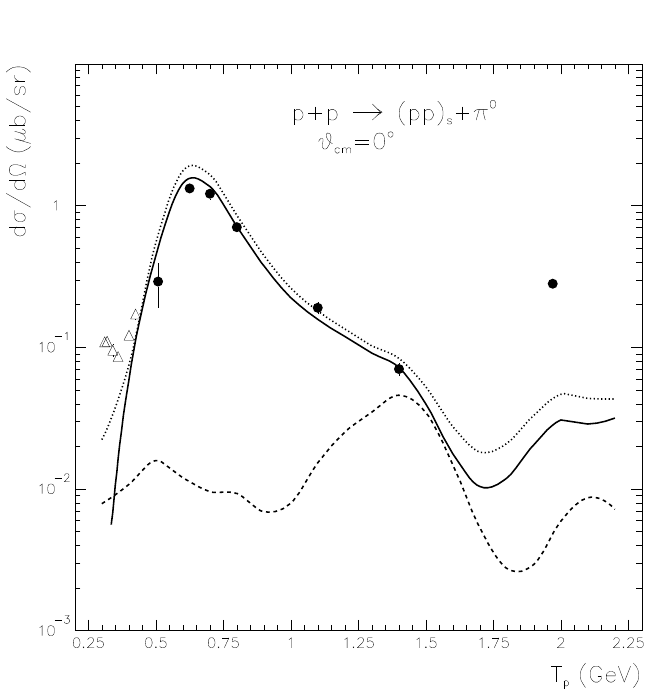
Figure 2. The cms cross sections of the reaction pp → { pp } s π 0 at θ = 0 ◦ versus beam energy. Data are taken from [13] ( (cid:52) ) and [5] ( • ). The dotted curve presents the calculated cross section for the incoherent sum of the direct and exchange terms of the OPE model amplitude. Other curves are obtained with the direct term A dir only for the isospin term a 3 excluded from (dashed line) and included (full line) in the 2 π 0 p → π 0 p amplitude, as explained in the text. All curves are scaled by the factor 0 .